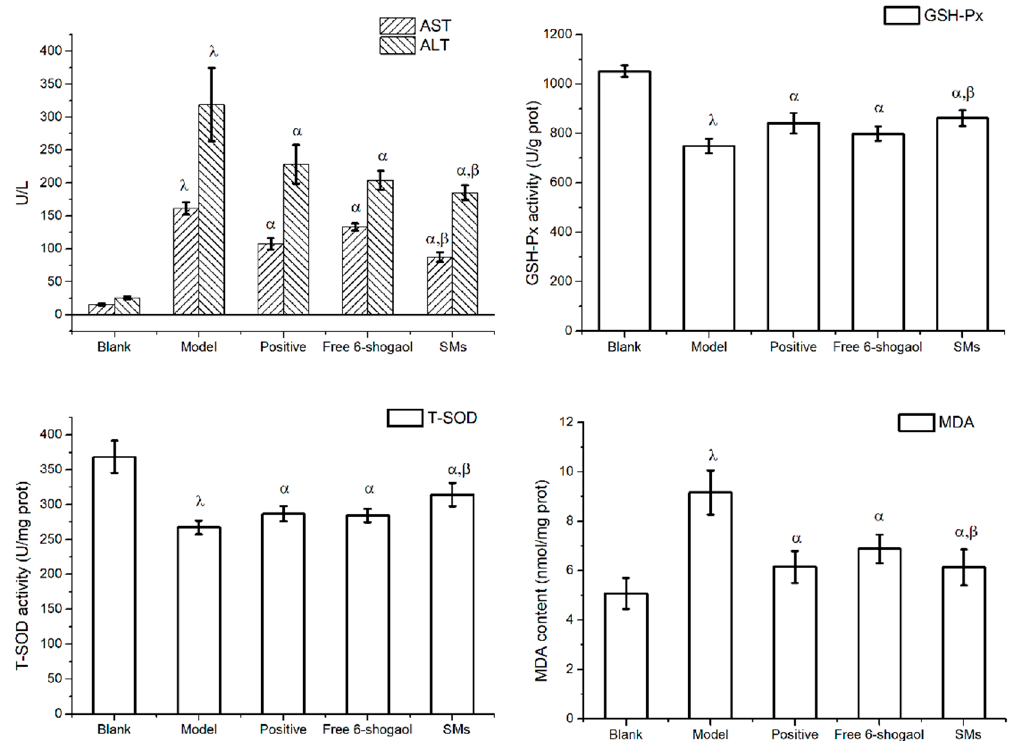
Figure 6. Effects of free 6-shogaol and SMs on serum ALT, AST activity ( A ) and liver GSH-Px ( B ), T-SOD ( C ) and MDA ( D ) activity. Animals were given orally: castor oil (model group); silymarin (positive group, 100 mg/kg); free 6-shogaol (100 mg/kg); or SMs (100 mg/kg) once daily for one week prior to the administration of CCl 4 (0.2%, i.p). Except blank group, which accepted the administration of castor oil. α P < 0.05 versus model group. β P < 0.01 versus free 6-shogaol. λ P < 0.05 model group versus blank group.